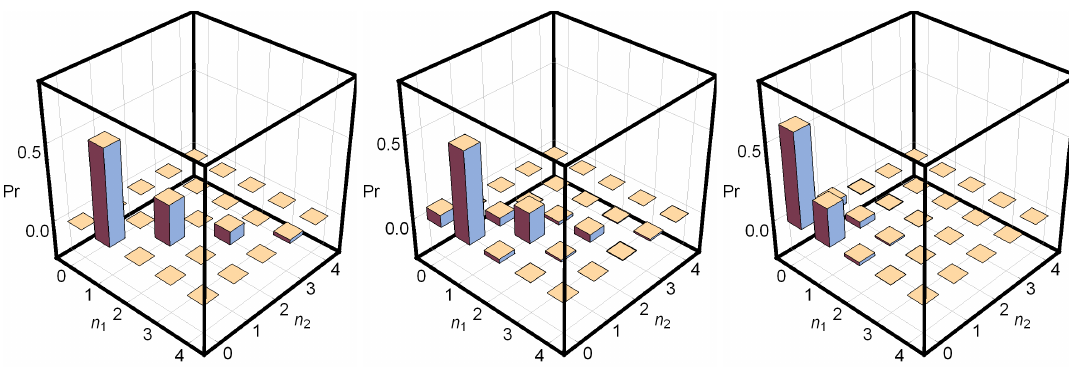
for an (cid:48) 2 1 , n